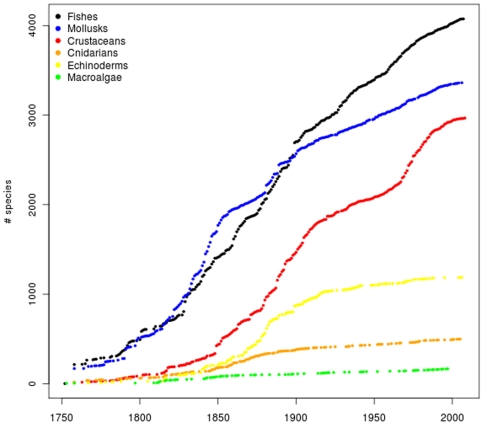
Species-description accumulation curves for South American marine
species by taxonomic group (macroalgae, cnidarians, mollusks,
crustaceans, echinoderms, and fishes).Data from OBIS database (using only “valid names” which
corrects for synonyms).